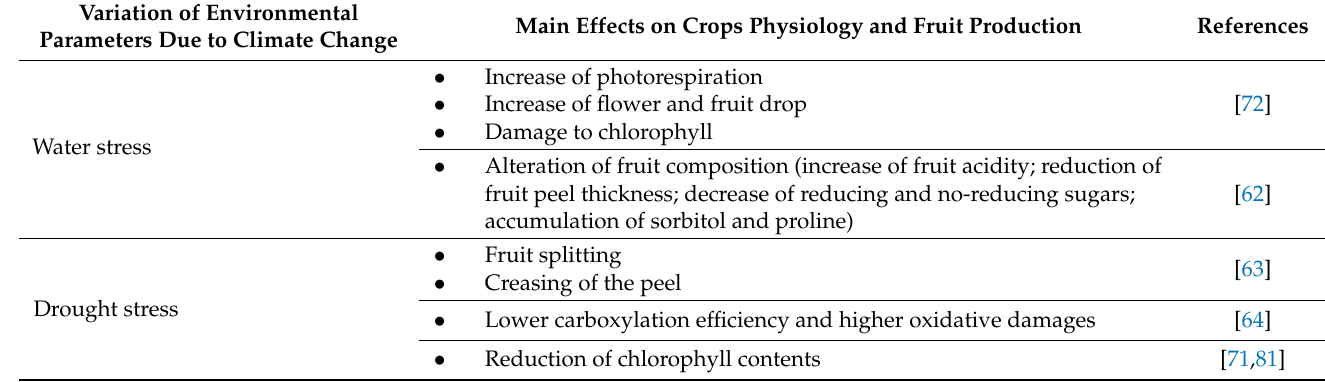
Table 1. Summary of principal effects of environmental conditions variation on the citrus